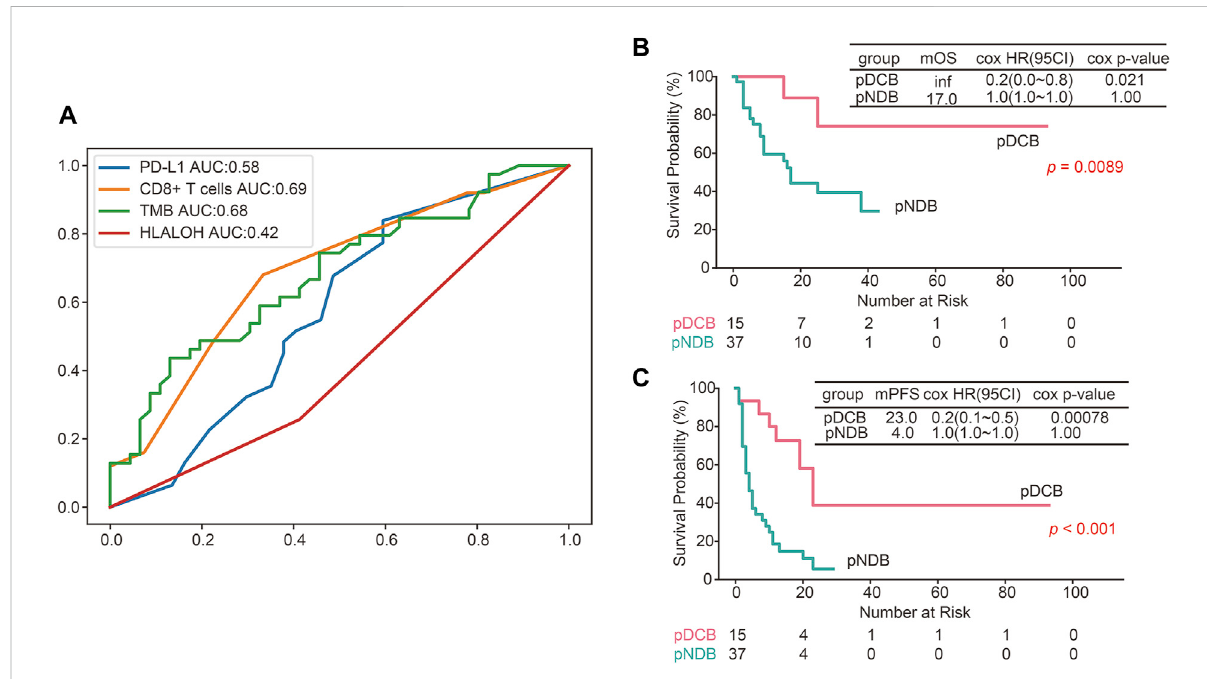
FIGURE 5 Thepredictiveef fi cacyoftheconstructedcomprehensivepredictivemodelwasbetterthanasinglebiomarker. (A) ROCcurvesforPD-L1,CD8 + T cells, TMB and HLA LOH. (B , C) Kaplan – Meier survival curves of OS (B) and PFS (C) comparing pDCB with pNDB in NSCLC